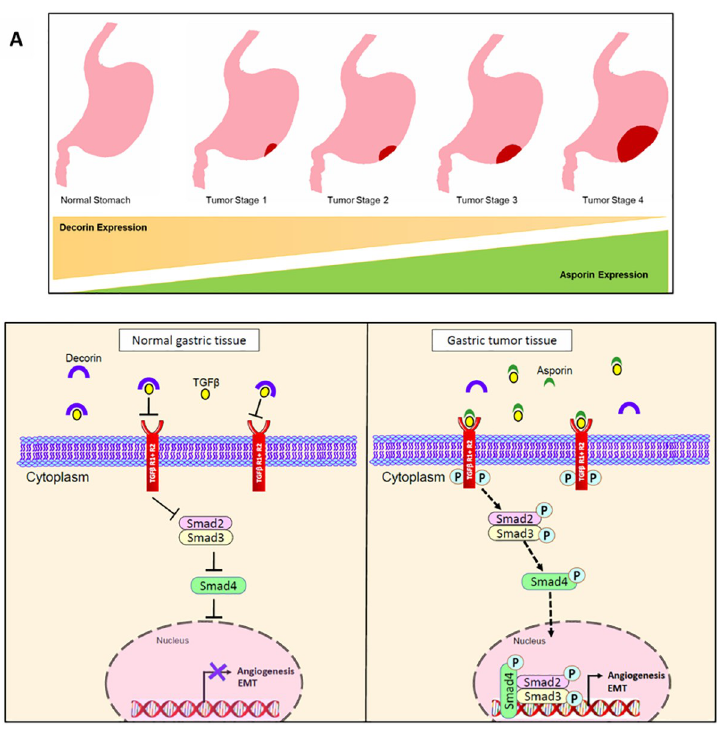
Fig 7. Model for regulatory mechanism of ASPN and DCN: We have proposed a Schematic illustration of the mechanism based on our conclusion. A. In normal gastric epithelium, ASPN is not present in the tumor microenvironment, DCN exerts its inhibitor activity by binding with TGF β ligand, thereby, impede TGF β signaling cascade and subsequent EMT, angiogenesis. (B). In GC tissue, DCN expression is lacking, ASPN binds with TGF β ligand, triggers the canonical pathway by phosphorylating Smad2 and Smad3. Phosphorylated Smads translocate to the nucleus and activates EMT and angiogenesis. Blunted lines, inhibition; dotted line, activation; cross, disrupted